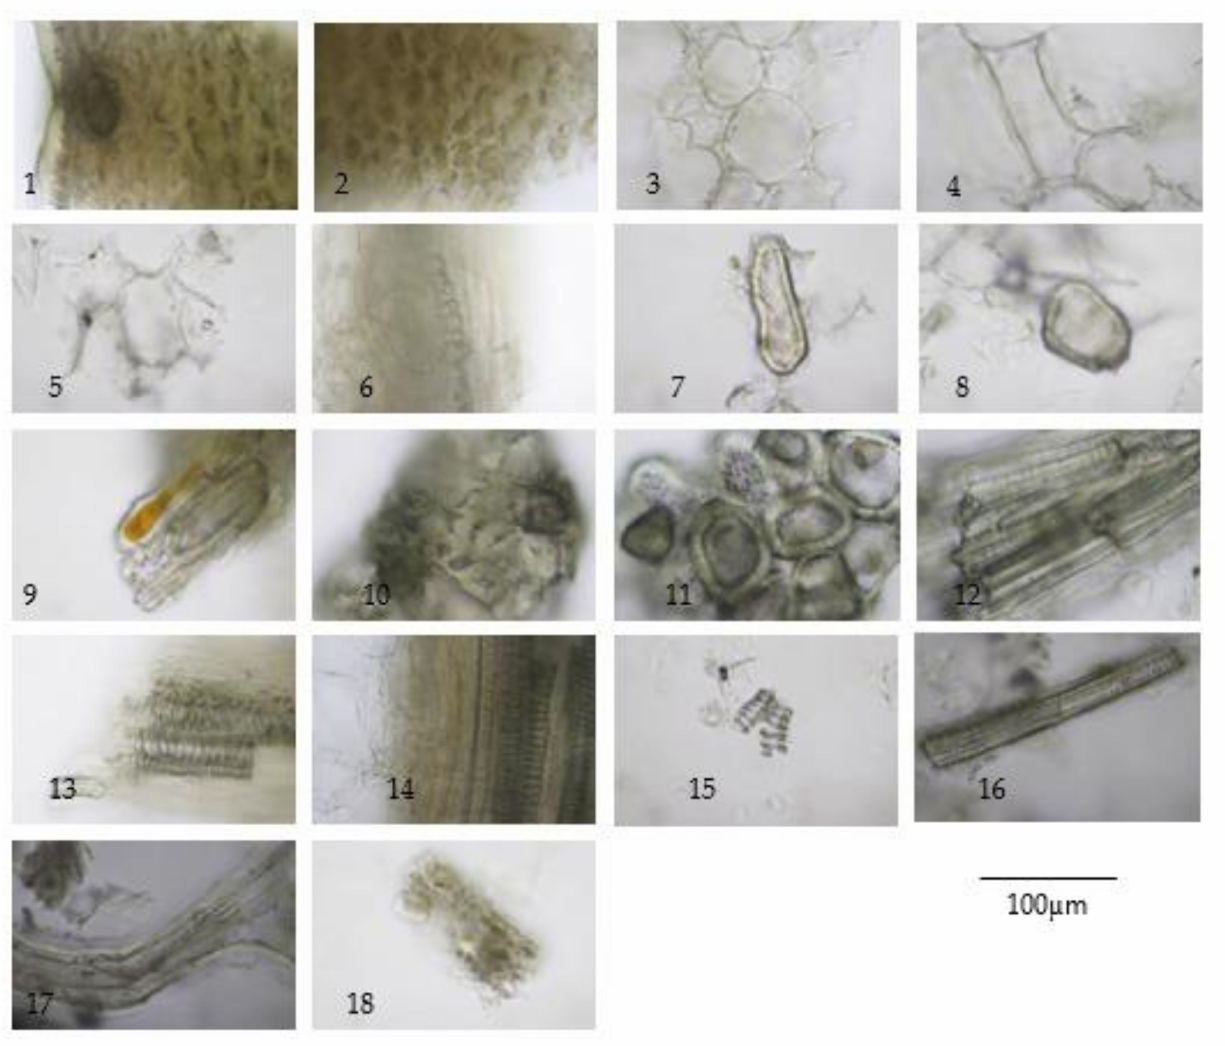
Figure 2. Diagnostic characteristics of Aegle marmelos (L.) Corr ê a fruit powder: ( 1 ) epicarp in cross-sectional view showing cuticle layer, epidermis, thick-walled parenchyma, and lysogenous oil cavities; ( 2 ) thick-walled parenchyma from epicarp; ( 3 ) thick-walled parenchyma from mesocarp showing intercellular spaces; ( 4 ) thick-walled parenchyma in longitudinal view; ( 5 ) parenchyma containing prismatic crystals; ( 6 ) in-line prismatic crystals; ( 7 , 8 ) sclereids; ( 9 – 11 ) group of stone cells from mesocarp; ( 12 ) group of sclereids from endocarp; ( 13 , 14 ) vascular bundle from mesocarp; ( 15 ) spiral vessels; ( 16 ) pitted vessel; ( 17 ) seed hair; and ( 18 ) cotyledon in sectional